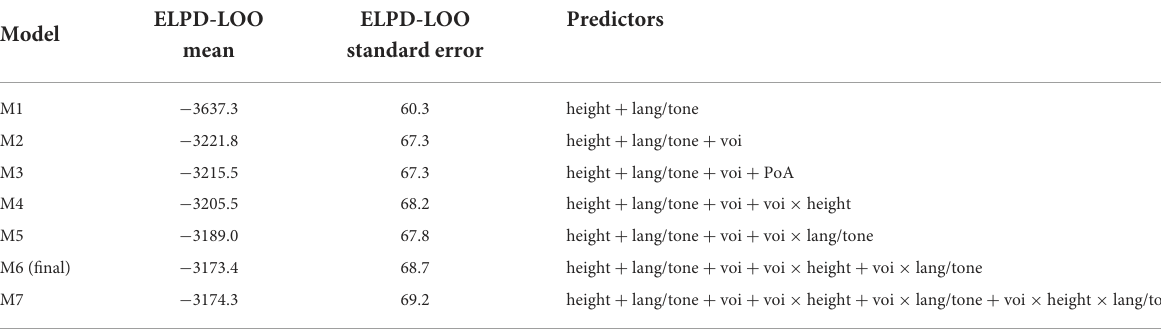
TABLE 2 Candidate post-stop F0 models considered in model comparison, with their ELPD-LOO means and standard